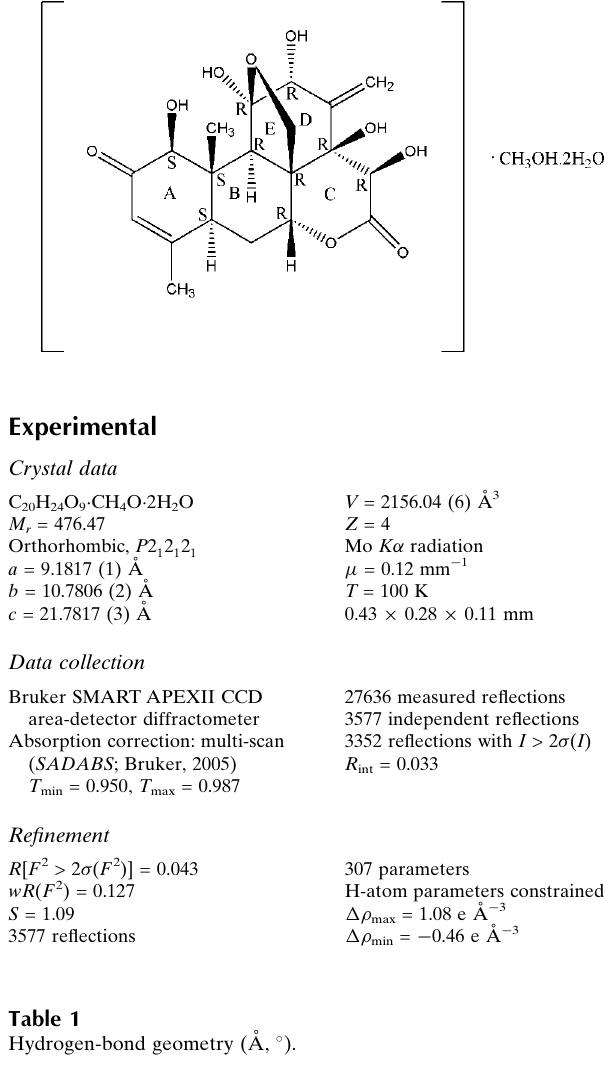
Hydrogen-bond geometry (A˚ , (cid:4)